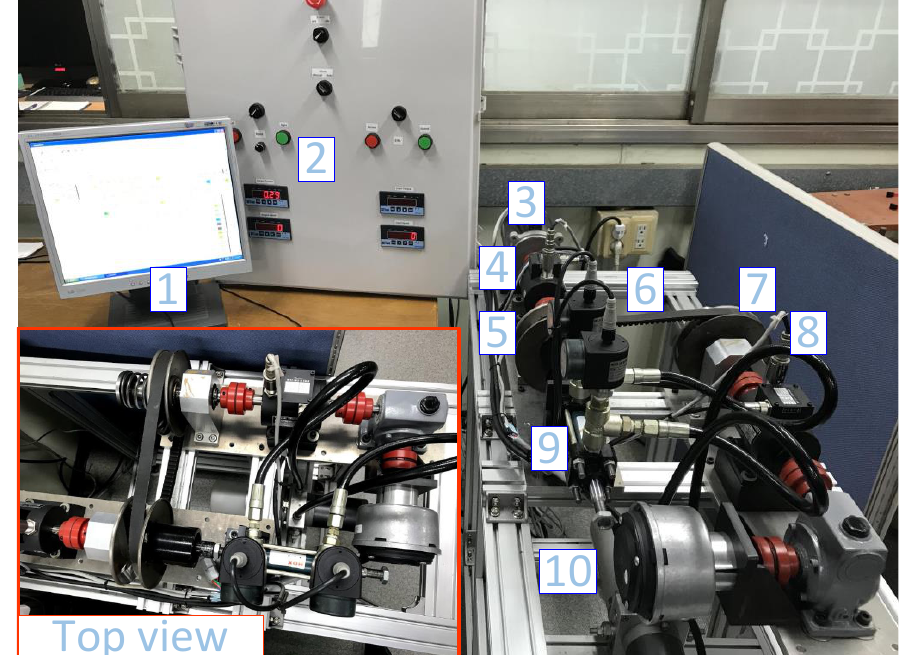
Figure 9. Experimental apparatus: ( 1 ) program computer with Simulink; ( 2 ) control system; ( 3 ) DC motor; ( 4 ) input speed sensor; ( 5 ) primary pulley with linear encoder; ( 6 ) belt; ( 7 ) secondary pulley; ( 8 ) output speed sensor; ( 9 ) cylinder; ( 10 ) Bosch Rexroth EHA.